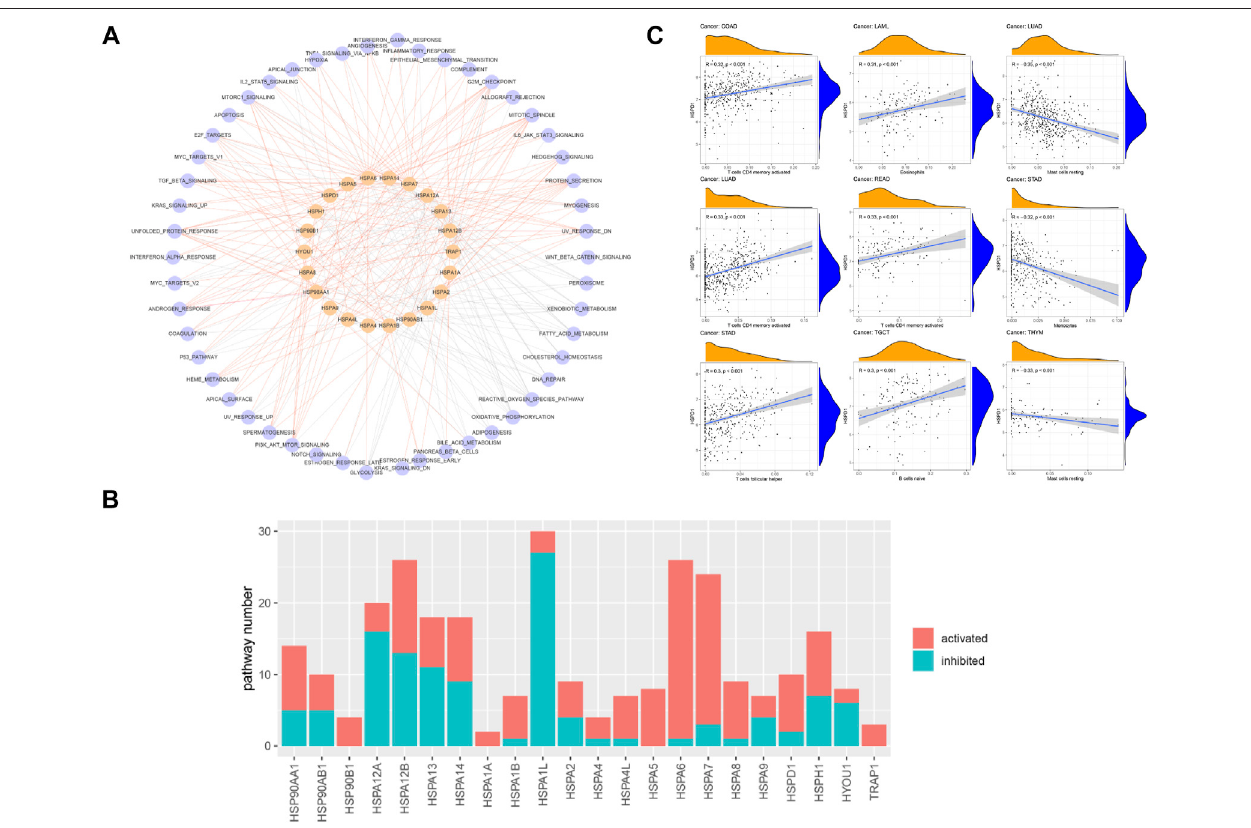
FIGURE 4 | The association of HSP expressions with cancer-related pathway and immune cell in fi ltration. (A) Network displaying the correlation between HSP expressions and cancer-related pathways. Pink color represents HSPs and blue color represents pathways. The red edges represent activated pathways and grey edges represent inhibited pathways. (B) Number of activated and inhibited pathways of each heat shock protein. Pink color represents activated pathways activity and blue color represents inhibited pathways activity. (C) Association of HSPD1 with different immune cell in fi ltration across different cancer types. HSP, heat shock